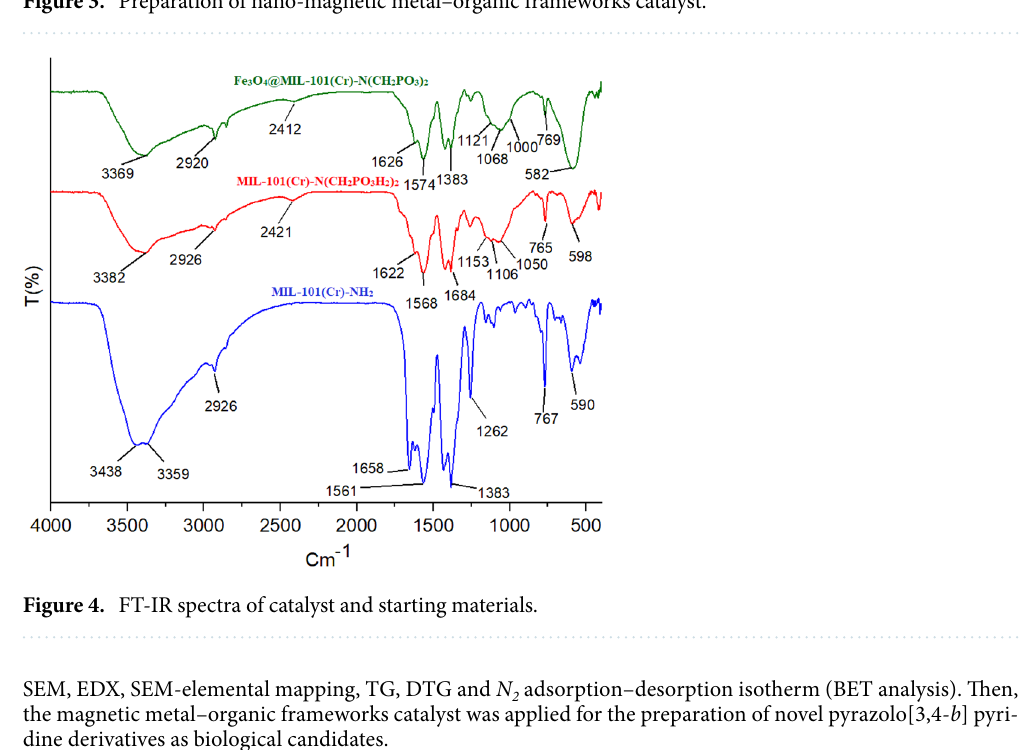
Figure 3. Preparation of nano-magnetic metal–organic frameworks catalyst.